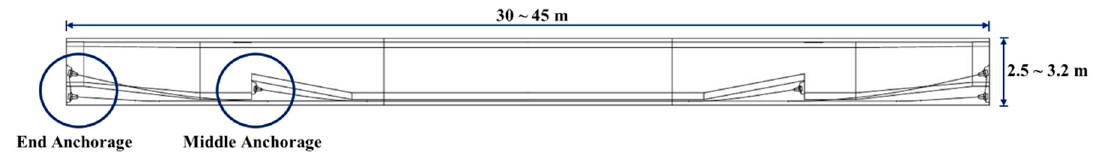
Figure 3. Longitudinal plan of railway bridge applying the new type of PSC I-girder.